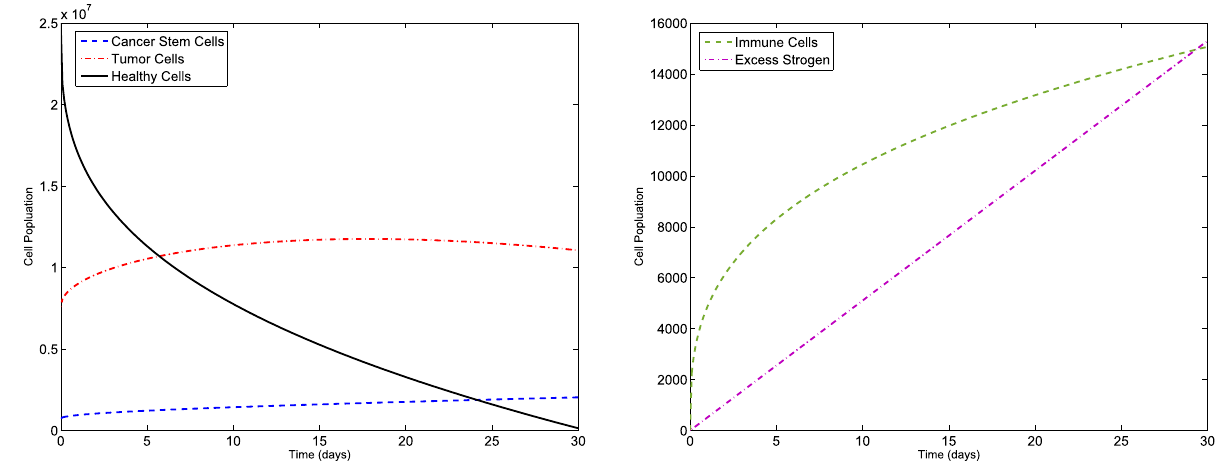
Figure 8. Evolution of { C ( t ) , T ( t ) , H ( t ) , I ( t ) , E ( t ) } vs time for the F-BCCM with m 1 = m 2 = m 3 = 6 ,